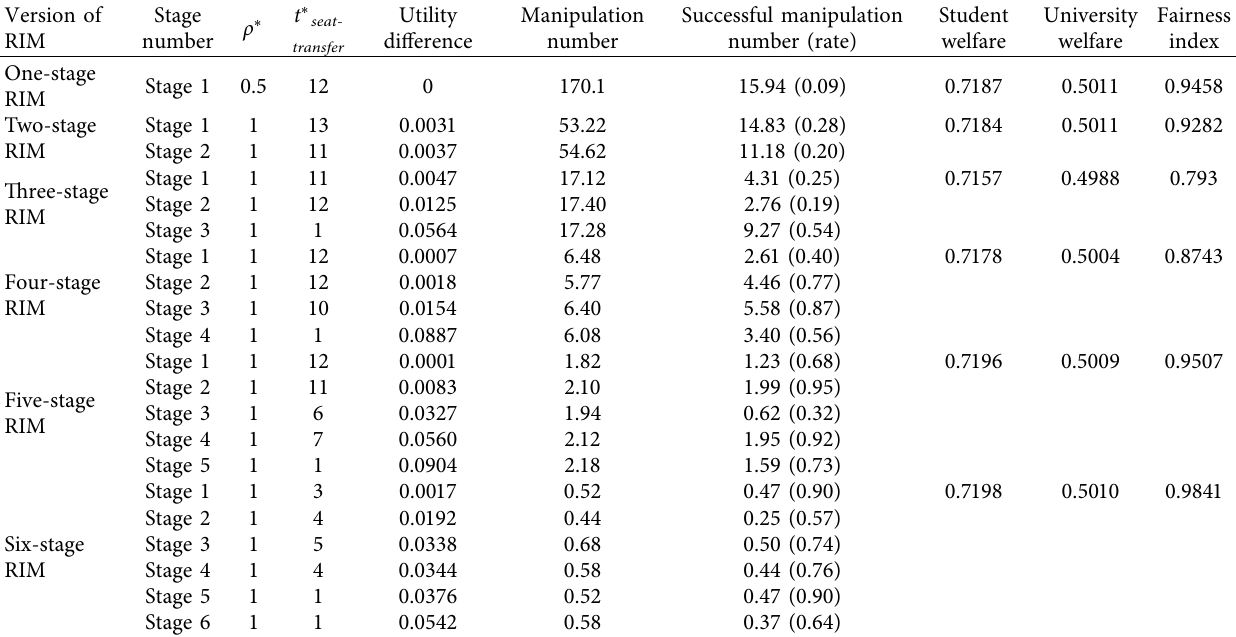
Table 1: Simulation results of different versions of